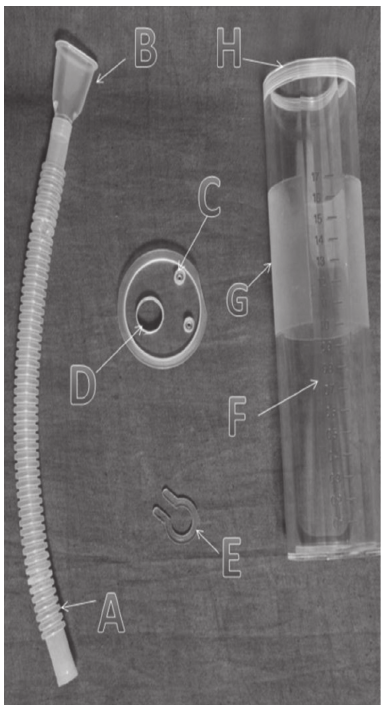
Figura 1 - Protótipo do dispositivo EPAP desenvolvido Legenda: A = mangueira; B = bocal; C = orifícios para escape de ar; D = orifício de passagem da mangueira; E = trava da mangueira; F = régua numérica; G = ranhuras; H = rosca de encaixe da tampa. Fonte: Dados da